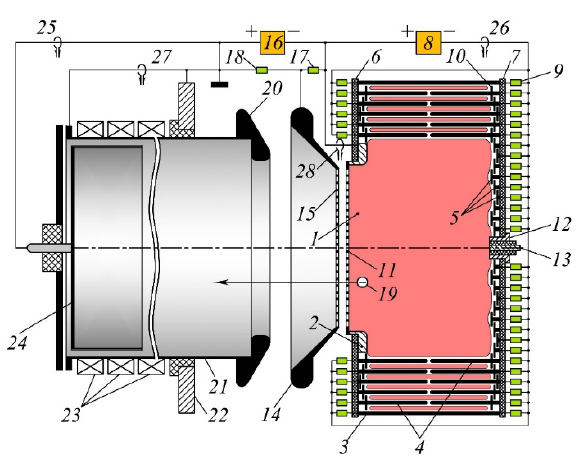
Fig. 6. Schematic of an electron gun with plasma emitter generated by the glow discharge with a multirod cathode.